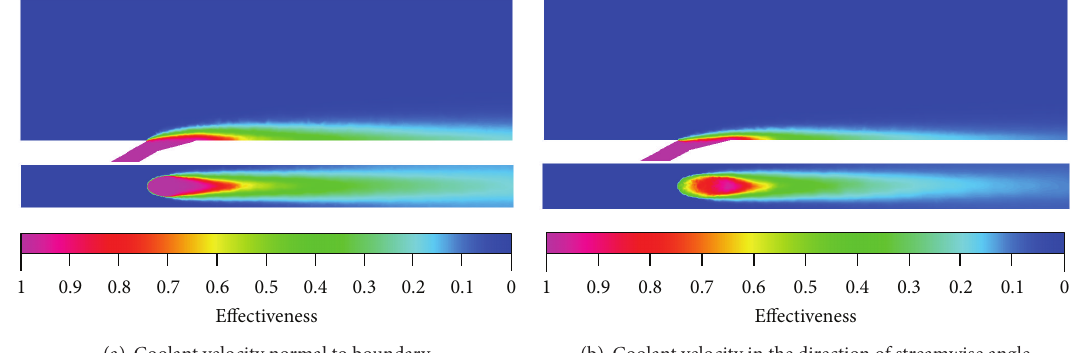
Figure 16: Top and symmetric planes of LFDSA 15-15 and 𝑀 = 0.45 .